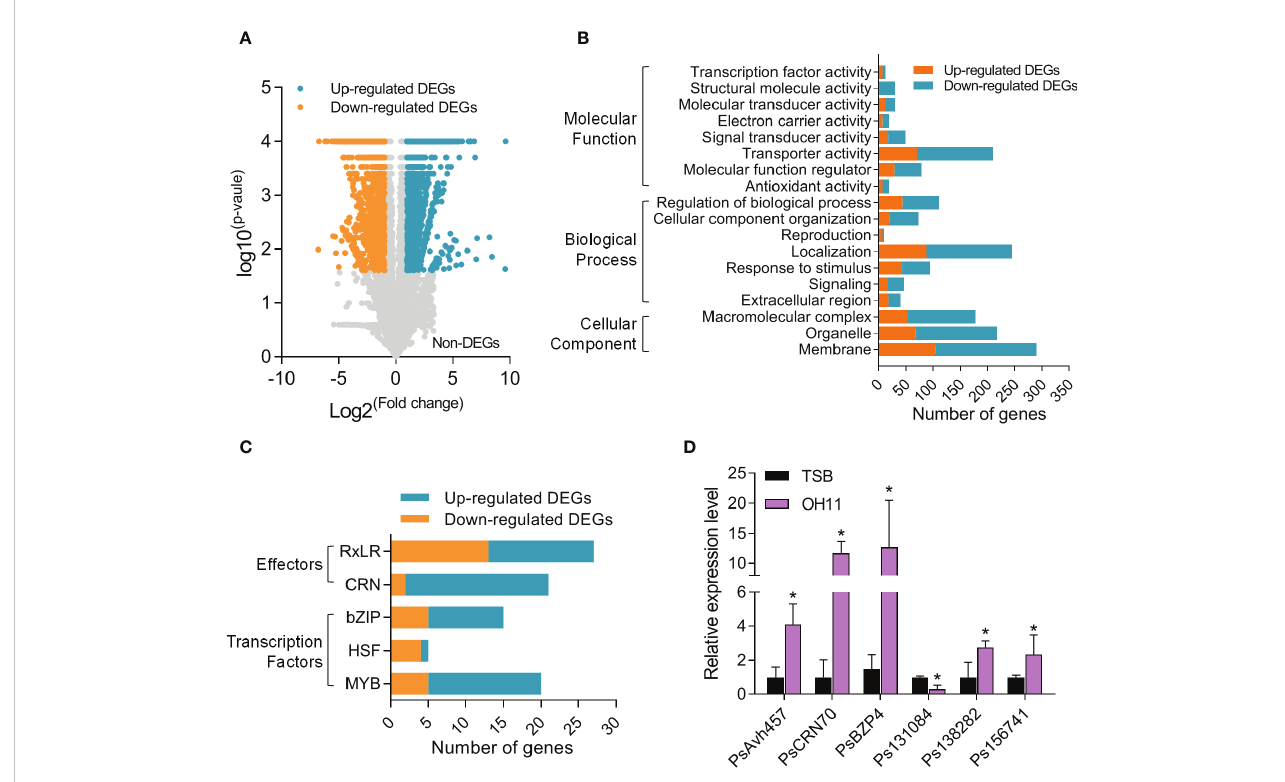
FIGURE 4 L. enzymogenes OH11 treatment resulted in global changes in P. sojae cyst gene expression. (A) Volcano plot of OH11-treated P. sojae DEGs (differentially expressed genes) compared to medium (TSB) control. Orange spots indicate the 1741 up-regulated genes; blue spots indicate the 2176 down-regulated genes; grey spots list those non-differentially expressed genes. (B) Number of DEGs categorized into different GO terms. (C) Number of DEGs categorized into different effector and transcription factor families. (D) Expression levels of representative DEGs veri fi ed by qRT-PCR. Three replicates of each sample were analyzed with a t-test. Asterisks indicate signi fi cant differences (P <